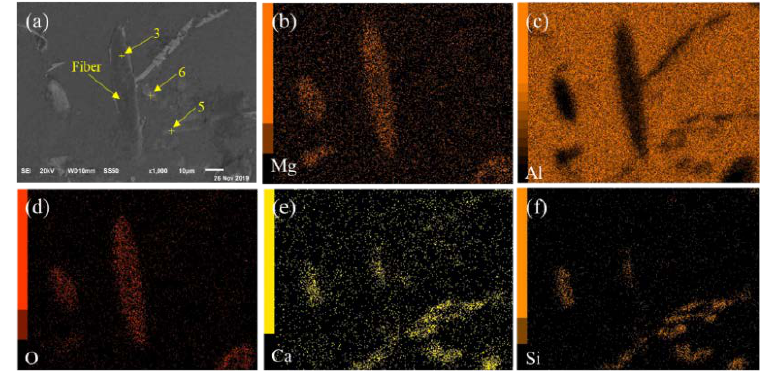
Figure 11. BF exposed in aluminum matrix after compression.